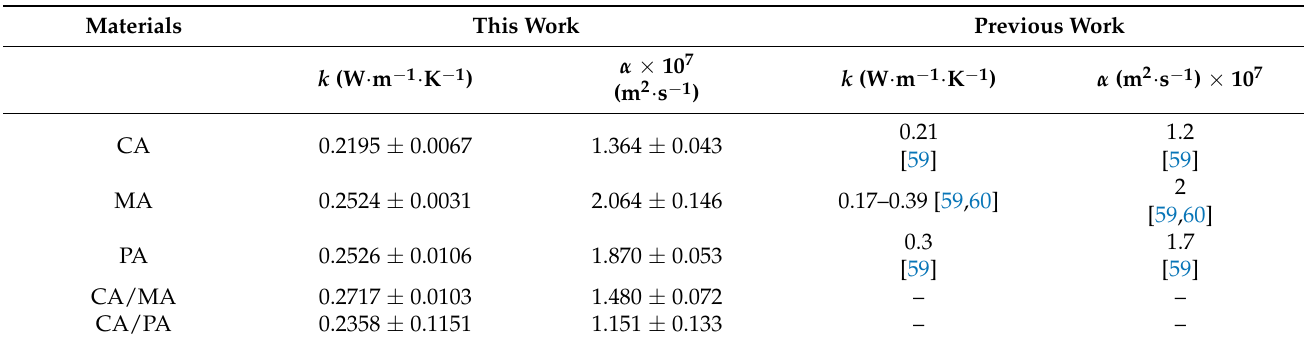
Table 9. Measured thermal conductivity and diffusivity in solid state at ambient temperature of fatty acids and eutectic mixtures compared with the literature [59,60] at pressure p = 0.1 MPa *. Materials This Work